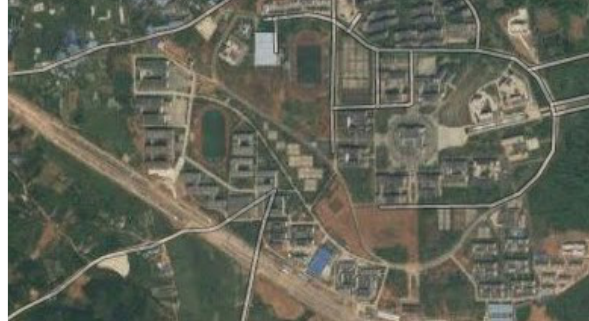
Figure 1. Research Area of the Bowen School of